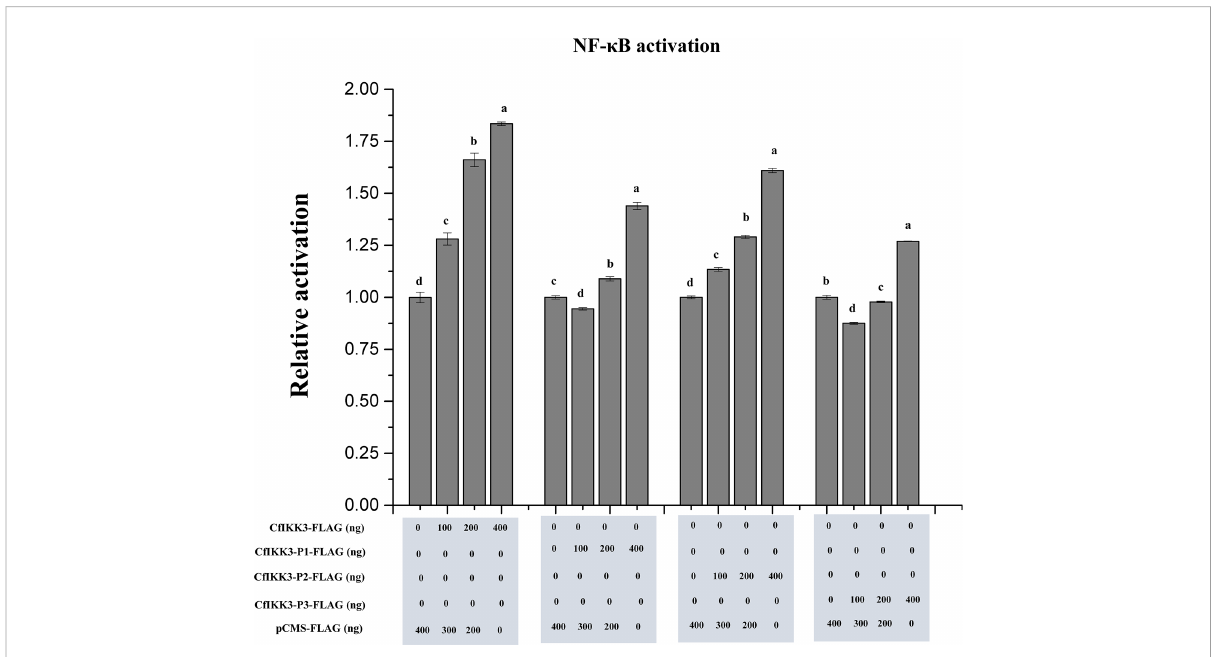
FIGURE 9 Activation of NF- k B reporter gene in HEK293T cells by overexpression of CfIKK3 protein or its truncated mutants, as veri fi ed using dual luciferase reporter gene assays. The results are represented as fold changes in the experimental groups compared to those in the control groups. Vertical bars represent mean ± SD (n = 3). Different letters indicate signi fi cant differences ( p <